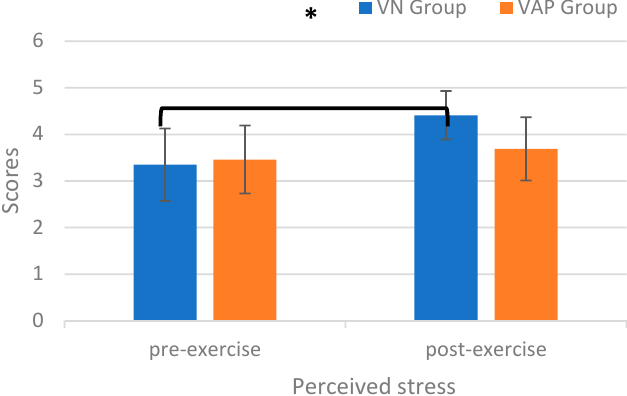
Figure 4. Perceived stress scores for the virtual nature (VN) and the virtual abstract painting (VAP) groups before and after the exercise intervention (* p < 0.05).